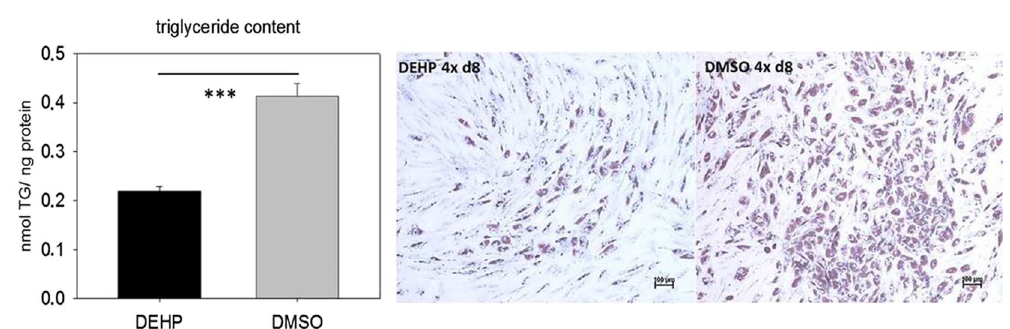
Figure 3. Triglyceride content of adipocytes after DEHP-exposure: SGBS cells were exposed to DEHP from d0– d4 and subsequently differentiated into adipocytes. For the triglyceride measurement (A) the cells were lysed at d8 in a special lysis buffer. Statistics: Student’s t-test (Wilcoxon rank-sum test); N = 2, n = 8. Light microscopy with a 4-fold magnification of Oil Red O stained adipocytes at d8 (B); scale bar = 100 µ